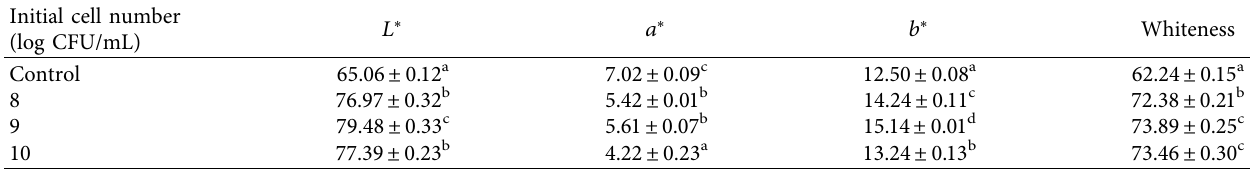
Table 3: Color values of hydrogels with diferent initial cell numbers.